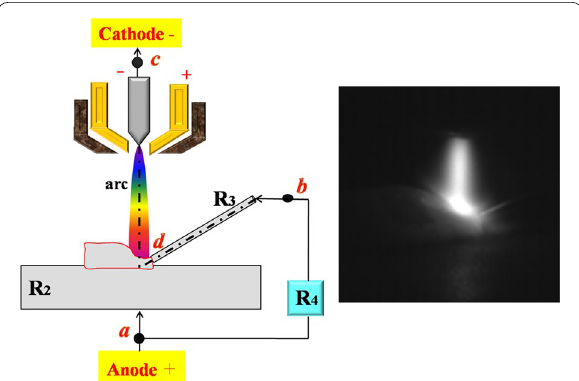
Figure 9 Circuit for DE-MPAW system in case of bridging-transfer